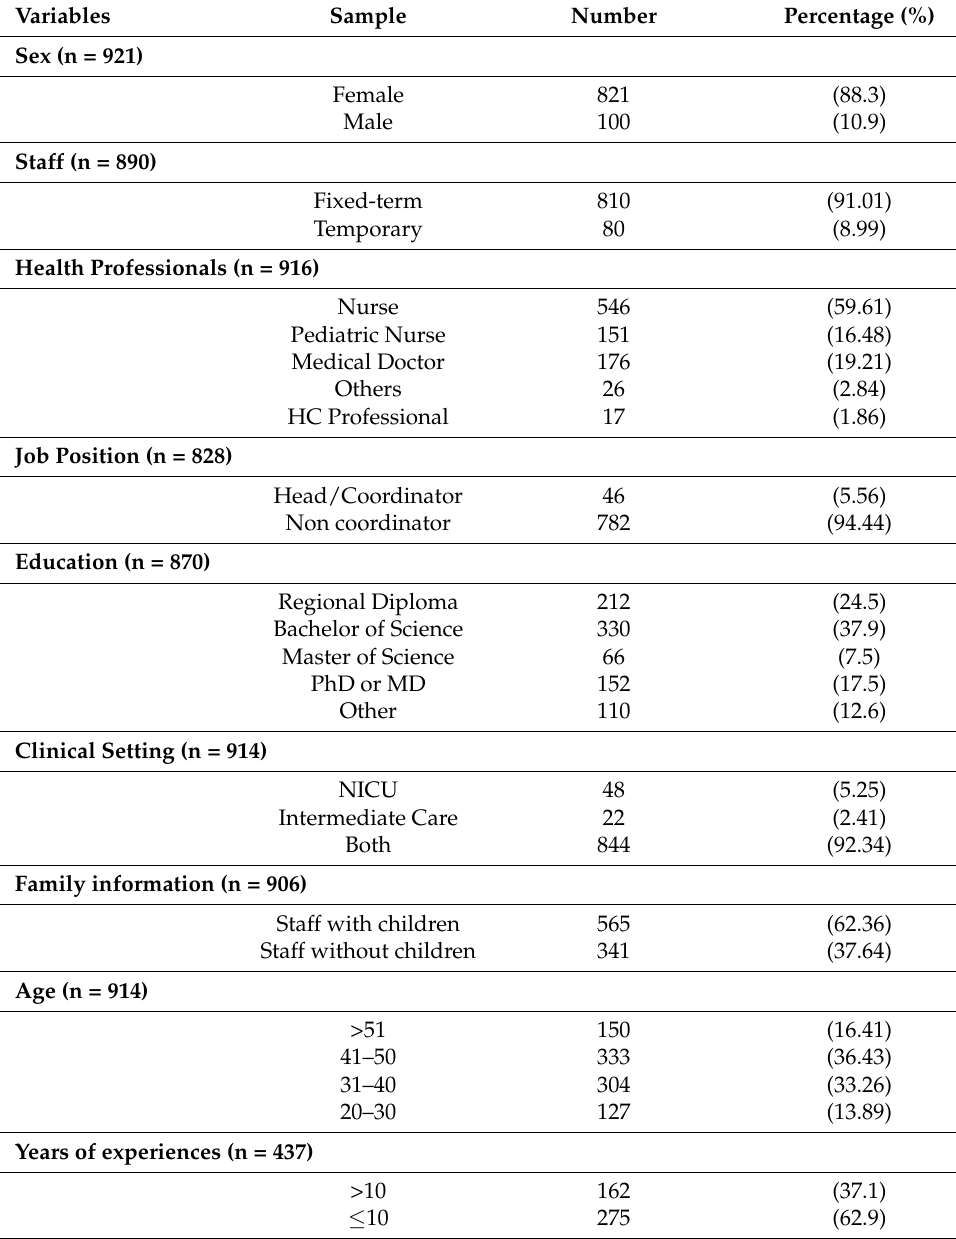
Table 1. Sociodemographic Characteristics of the Sample (n =